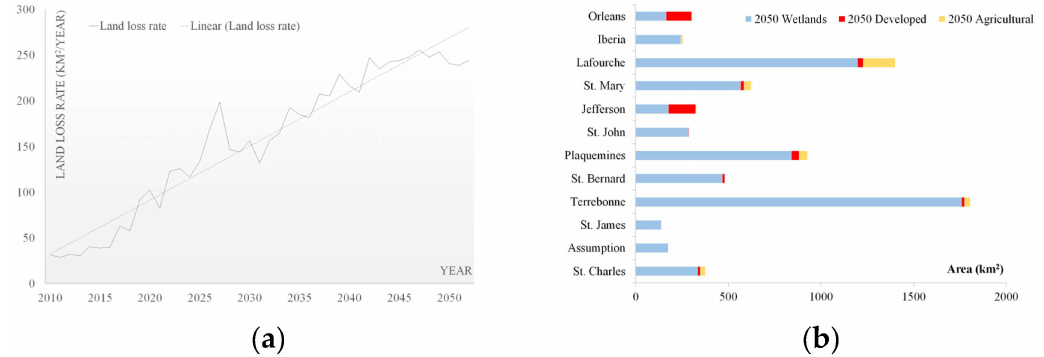
Figure 7. ( a ) Potential land loss rate from 2011 to 2050; ( b ) potential land loss types and areas by parish in the south